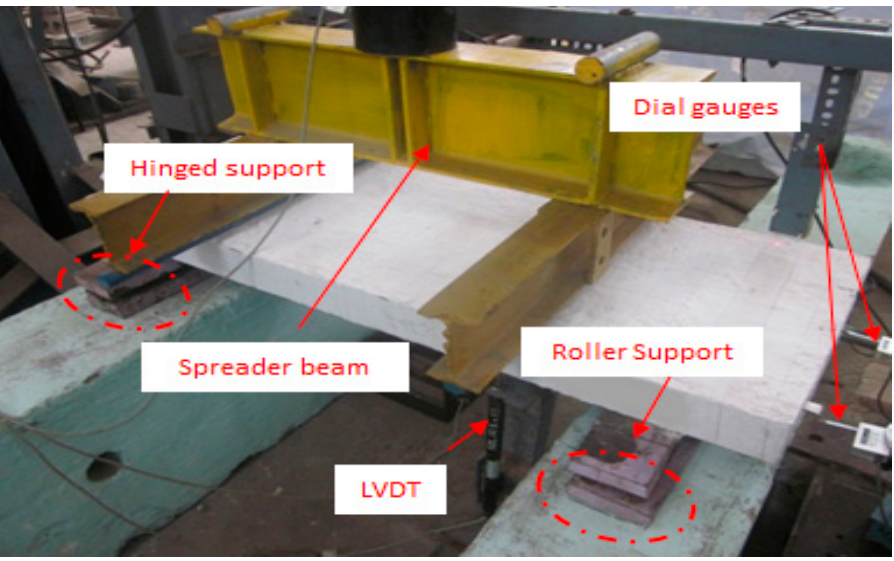
Figure 8. Experimental setup for flexural strength test of composite slab specimens.